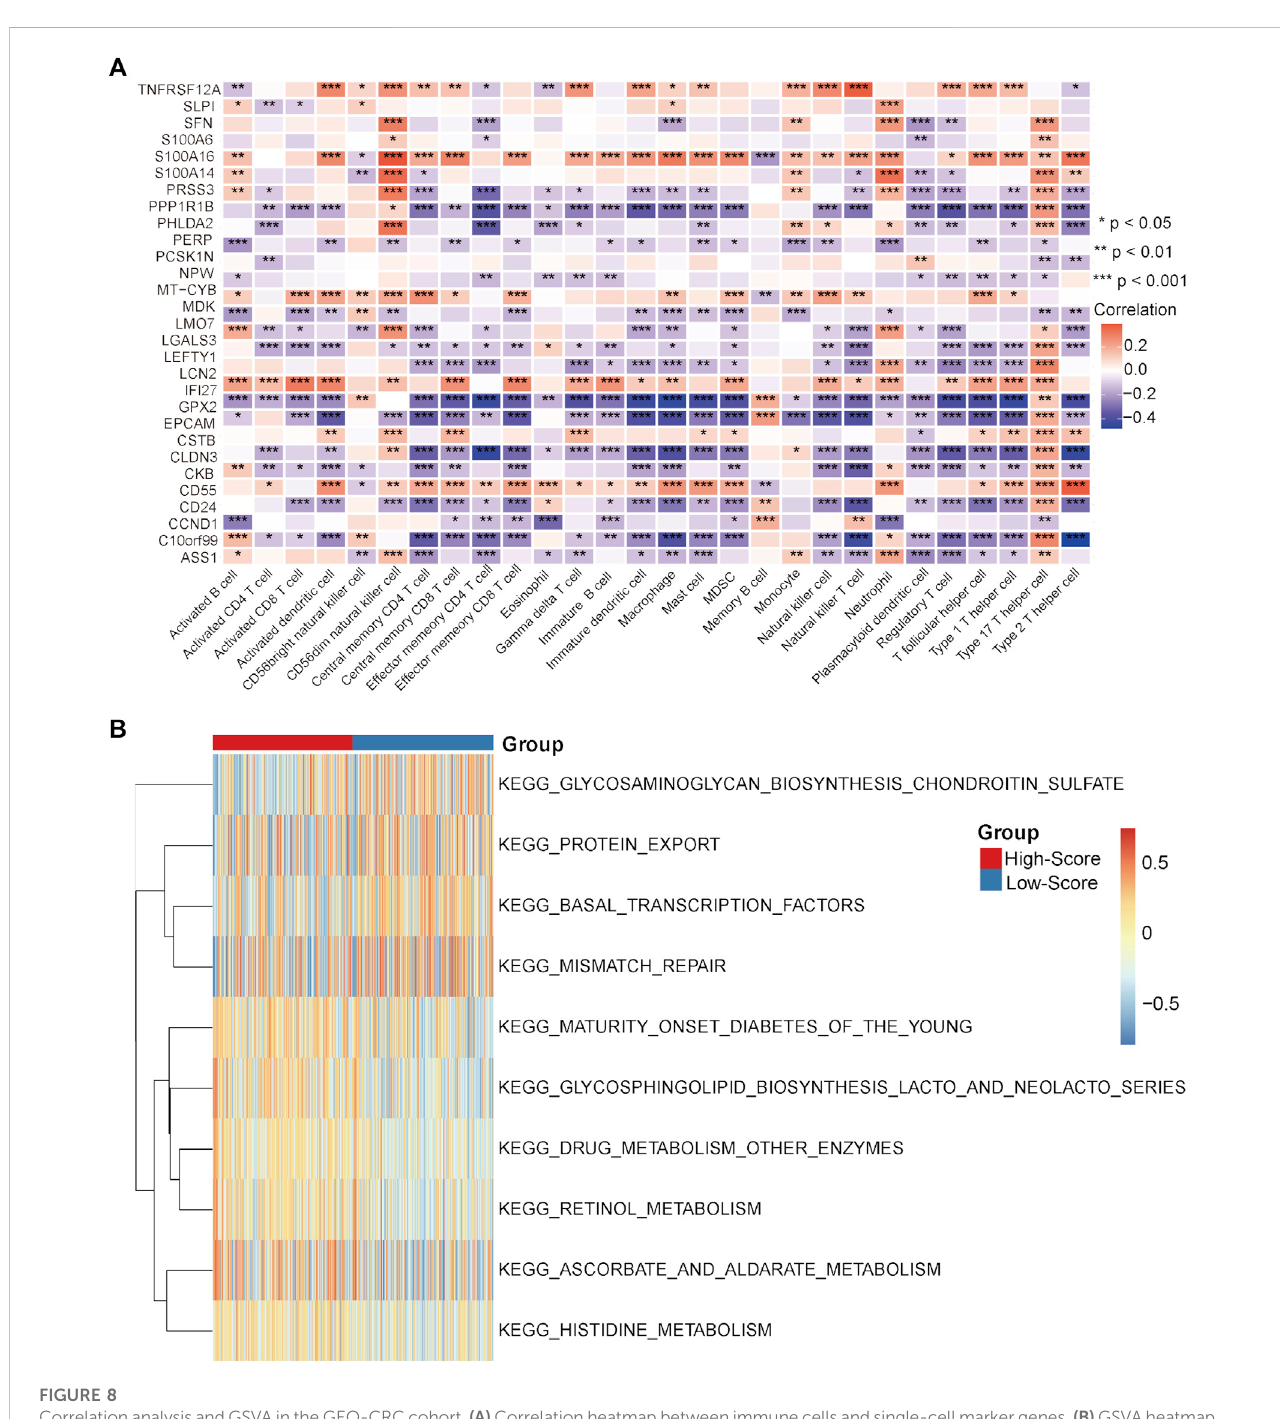
FIGURE 8 Correlation analysisandGSVAintheGEO-CRC cohort. (A) Correlationheatmapbetweenimmunecellsandsingle-cellmarkergenes. (B) GSVAheatmap between the high- and low-score groups. * p < 0.05, ** p < 0.01, *** p < 0.001, **** p < 0.0001, ns, not signi fi